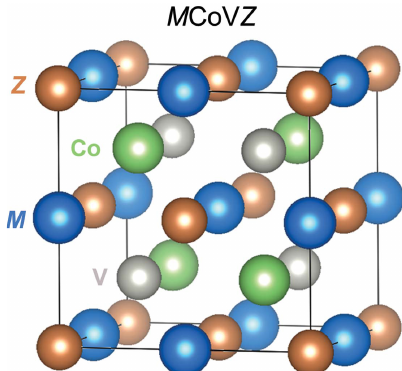
Figure 1 Atomic arrangement for the M CoV Z Heusler materials studied by Wang et al. (2017) ( M = Y, Lu; Z = Si,